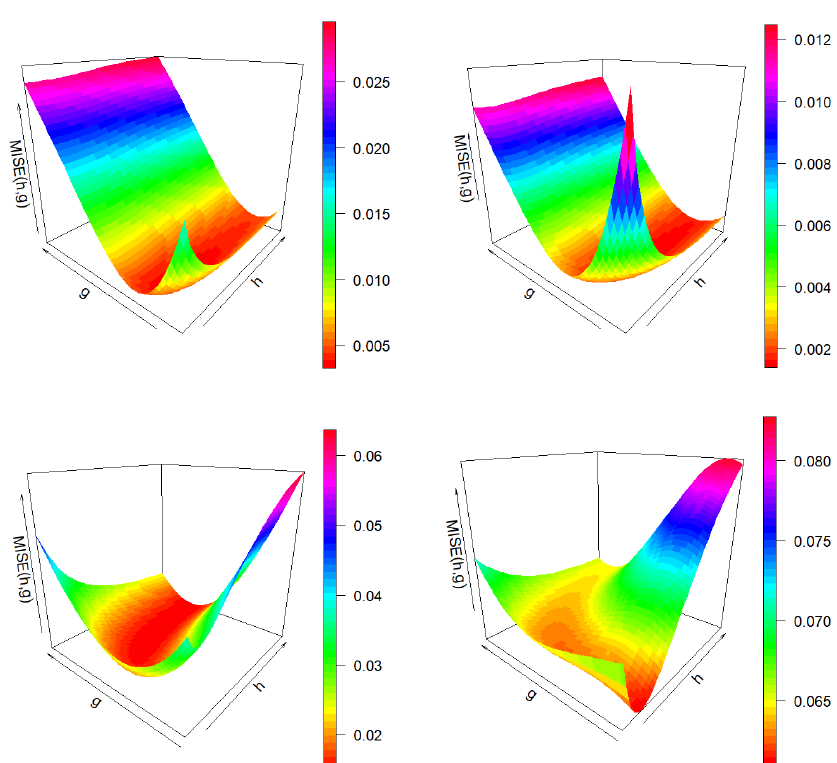
Figure 4. MISE x ( h , g ) function approximated via Monte Carlo ( left ) and MISE ∗ x ( h , g ) function approximated via bootstrap ( right ) for one sample from Model 1 ( top ) and Model 2 ( bottom ) when P ( δ = 0 | x ) = 0.5.